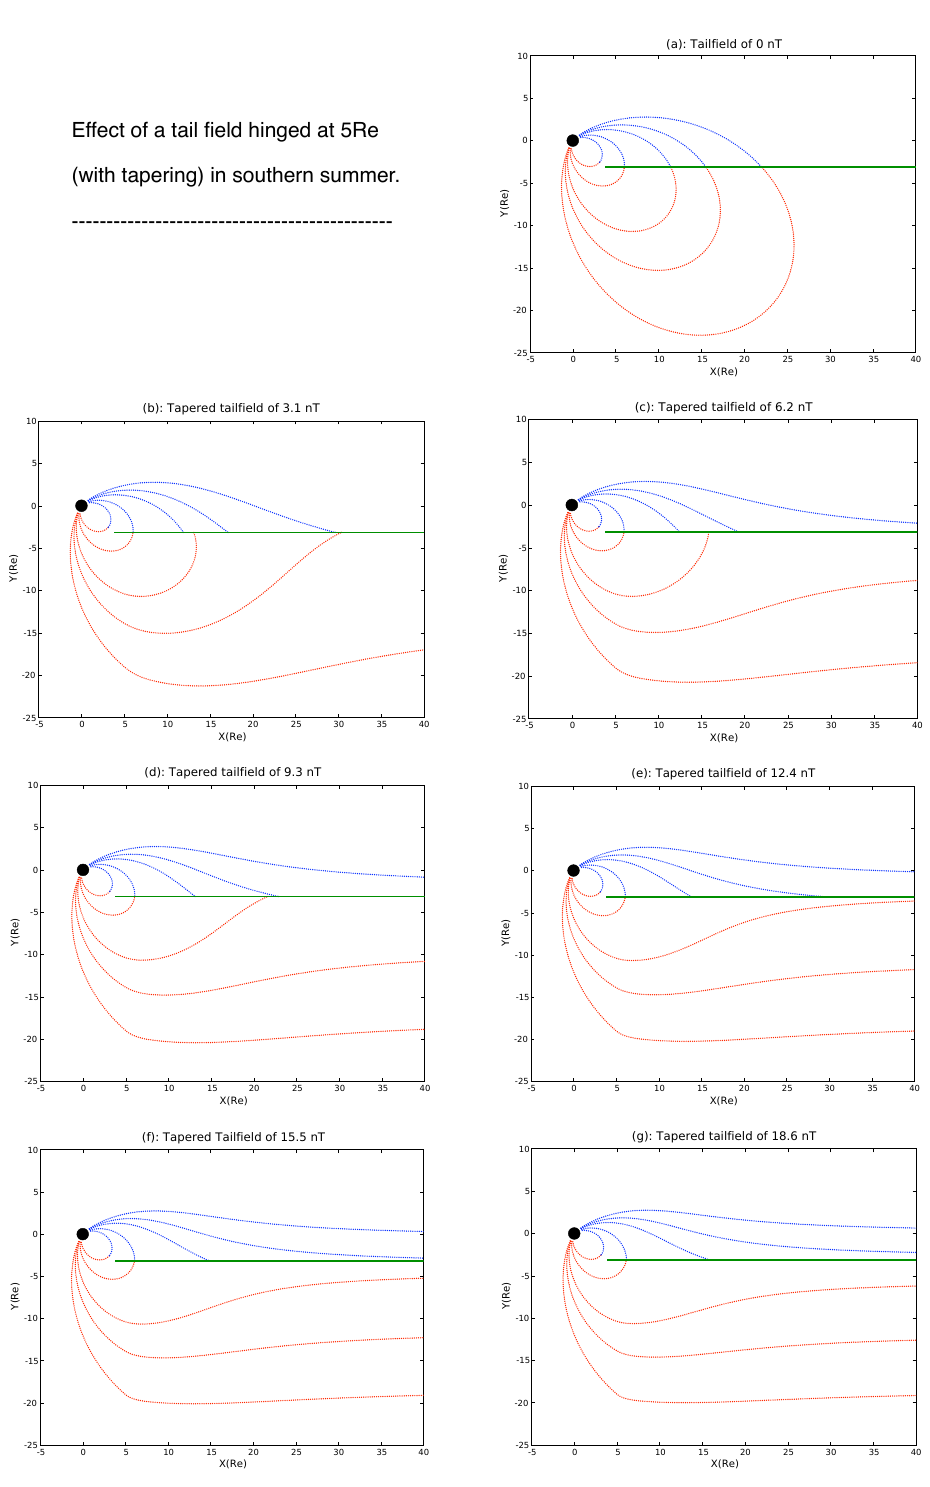
Fig. 7. Field-line tracings on the night side for L=4, 7, 14, 20 and 30, showing the effect of increasing tail field. The neutral sheet has been “hinged” to the dipole field at 5 R E (see text). In the Antarctic summer the angle between the geomagnetic equator and the ecliptic plane is 39 ◦ . The third line out represents the L-value of South